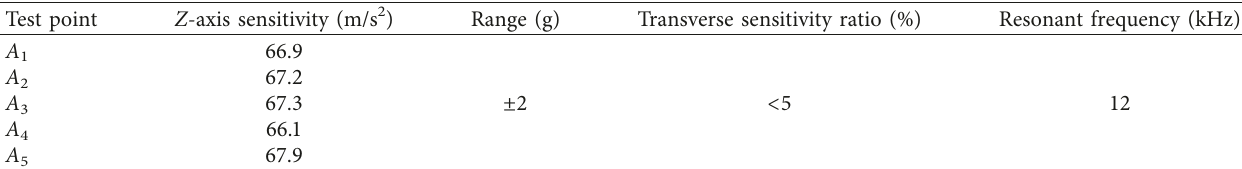
Table 4: Parameters of the three-way capacitive accelerometer.